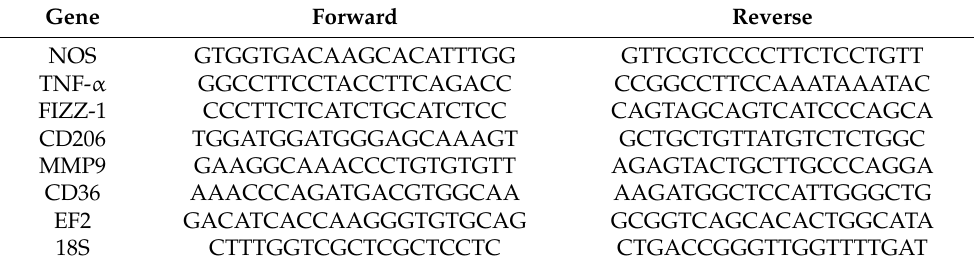
Table 1. PCR primers